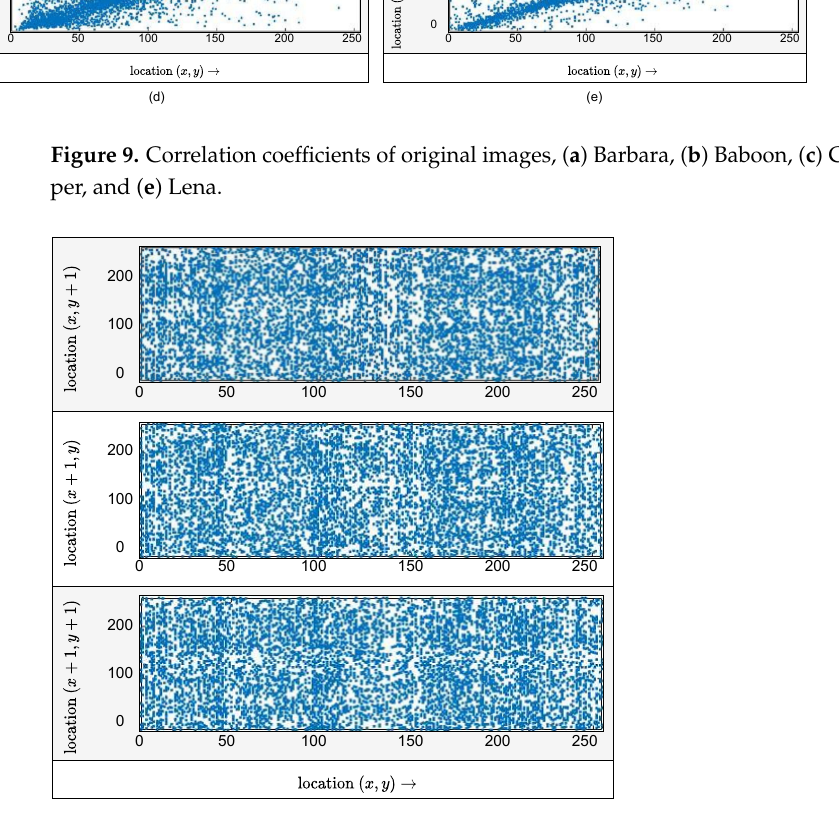
Figure 10. Correlation coefficients (H, V, and D components) of all encrypted test